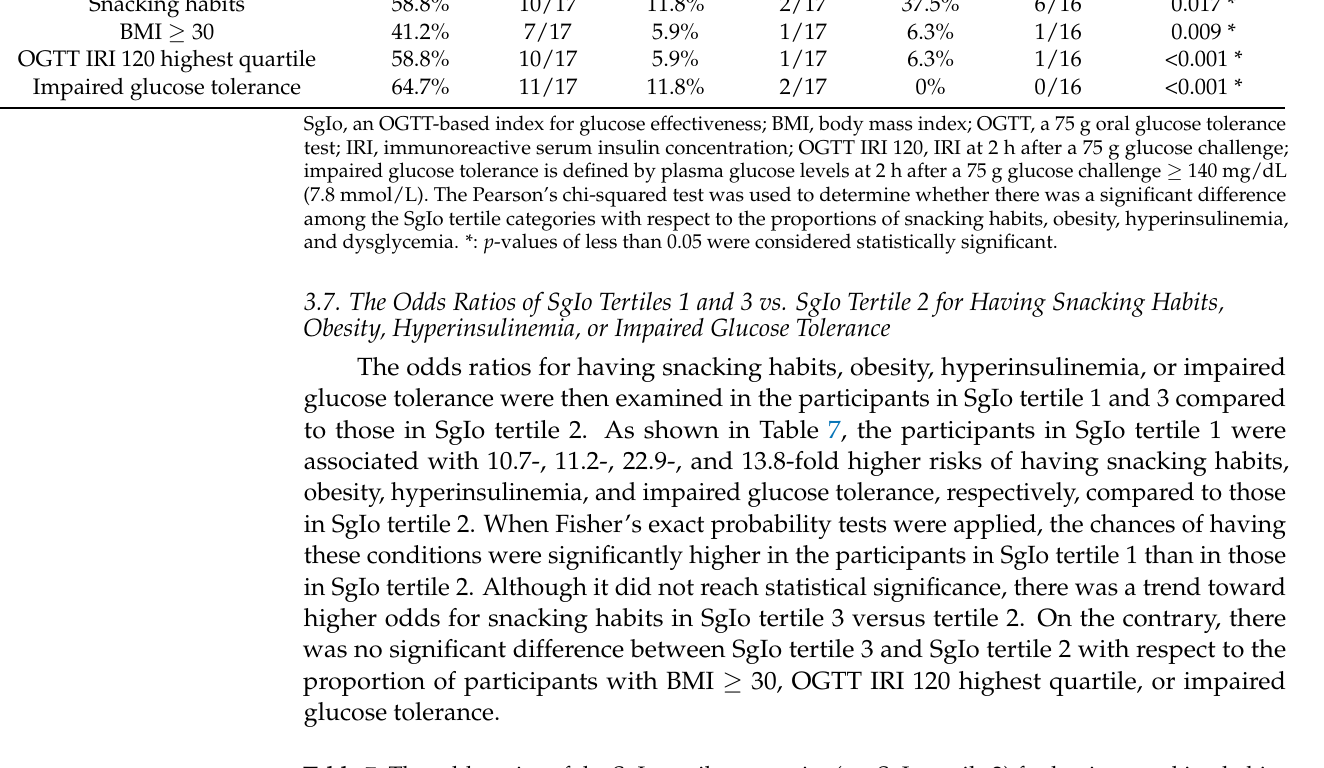
Table 7. The odds ratios of the SgIo tertile categories (vs. SgIo tertile 2) for having snacking habits, obesity, hyperinsulinemia, or impaired glucose